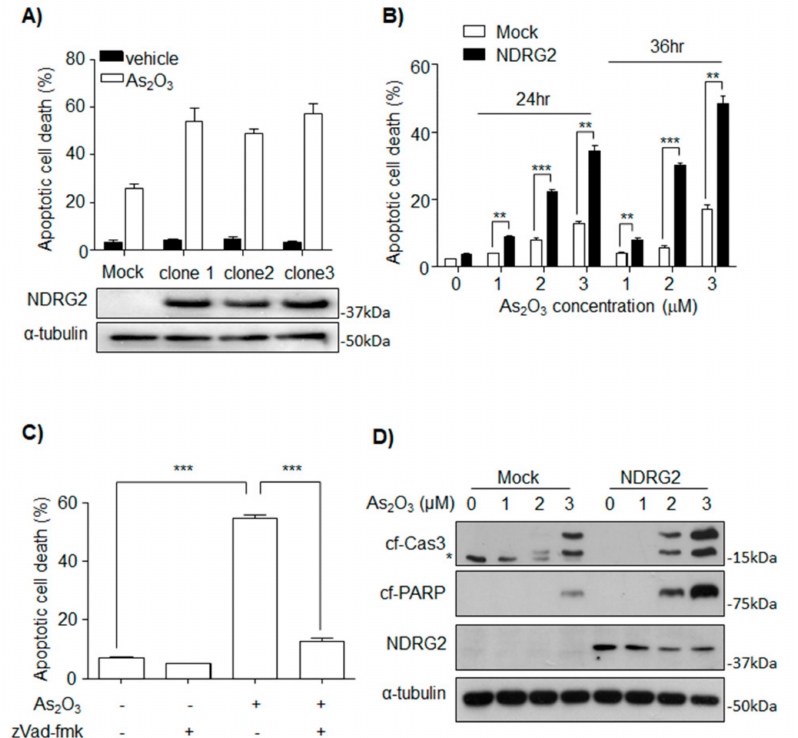
Figure 1. N-Myc downstream-regulated gene 2 (NDRG2) overexpression sensitized U937 cells to As 2 O 3 in a caspase-dependent manner. ( A ) U937-Mock and three U937-NDRG2 lines were incubated with As 2 O 3 (2 µ M, 24 h). The cells were stained with Annexin V / propidium iodide (PI) and analyzed by flow cytometry. ( B ) The cells were incubated with As 2 O 3 at the indicated time and concentration, and apoptotic cell population was validated with Annexin V / PI staining. ( C ) Here, 2 µ M As 2 O 3 was treated in the presence or absence of zVad-fmk (Pan-caspase inhibitor, 50 µ M). The apoptotic population was validated with Annexin V / PI staining. ( D ) U937-Mock and U937-NDRG2 cells treated with As 2 O 3 at the indicated dose. The cleavages (Cf) of Caspase3 and PARP were analyzed by immunoblotting. * is non-specific band. ** p < 0.01, *** p < 0.005 determined from t -tests. Data are presented as means ± standard error of the mean